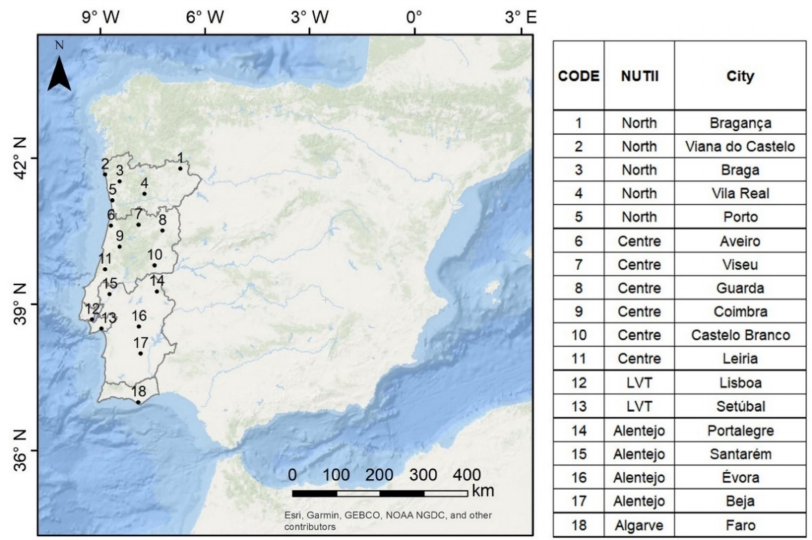
Figure 1. Portugal and NUTS II (grey area) location in the Iberian Peninsula.